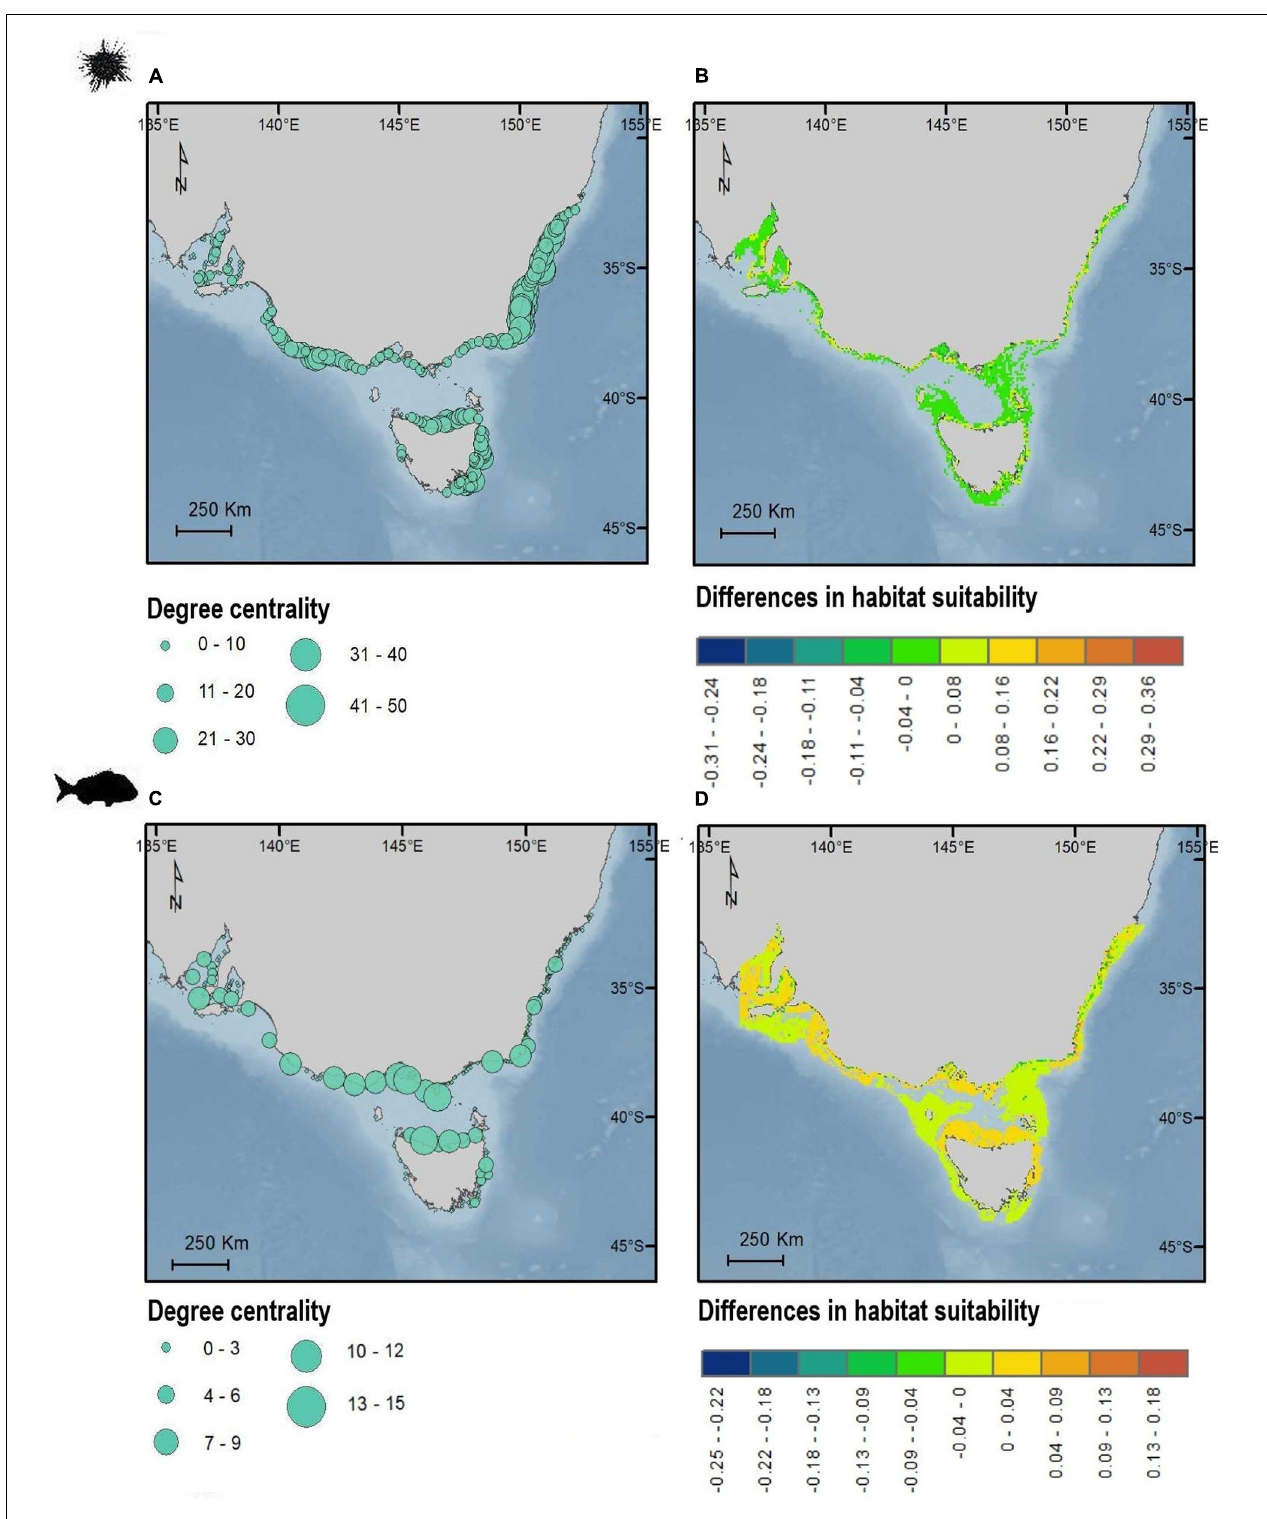
FIGURE 4 | Maps showing the geographic distribution of degree centrality (A,C) and differences in spatial predictions of habitat suitability (B,D) for sea urchin H. erythrogramma (top) and snapper , C. auratus (bottom). Degree centrality (A,C) is shown as dots corresponding to the habitat patches centroids. Values of habitat suitability are positive when predicted habitat suitability is larger for SDM incorporating connectivity compared to the SDM without connectivity. Values of habitat suitability are negative when predicted habitat suitability is lower for SDM incorporating connectivity compared to the SDM without connectivity. Maps in WGS84.